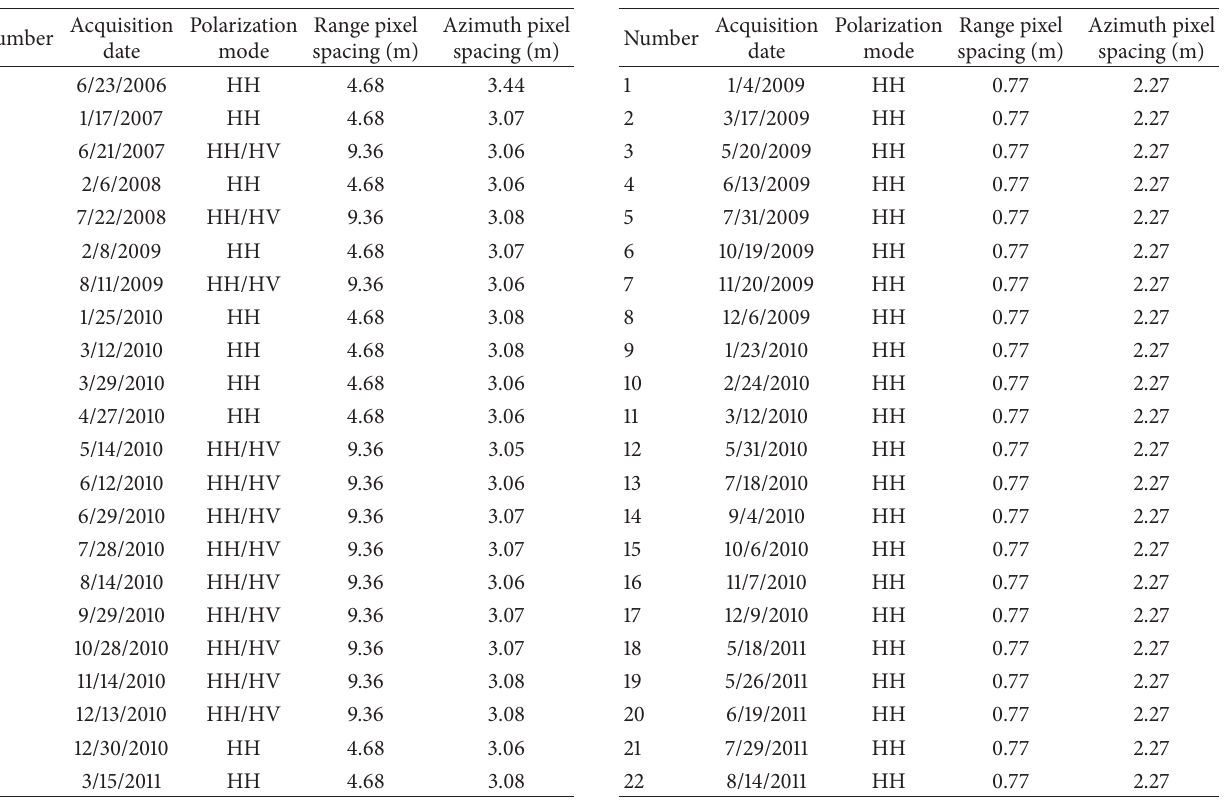
Table 1: Detailed parameters of the ALOS PALSAR data used in this paper.